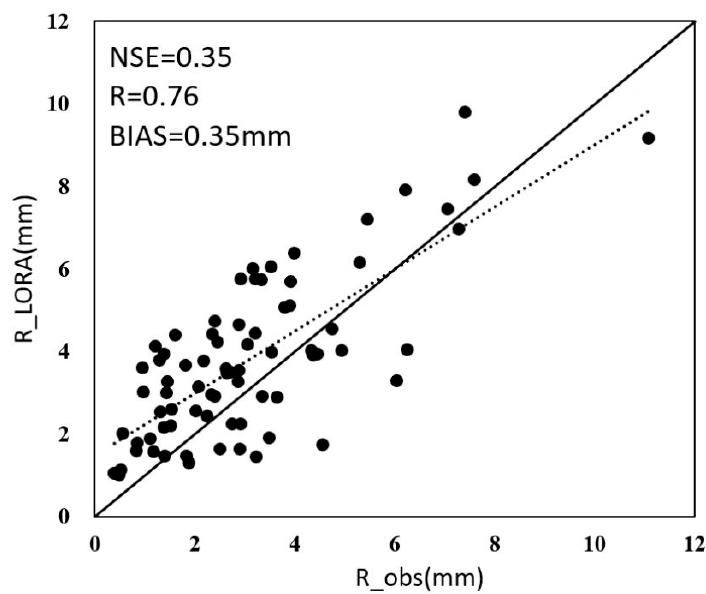
Figure 6. Verification results of LORA runoff data by observation data of the hydrological stations.